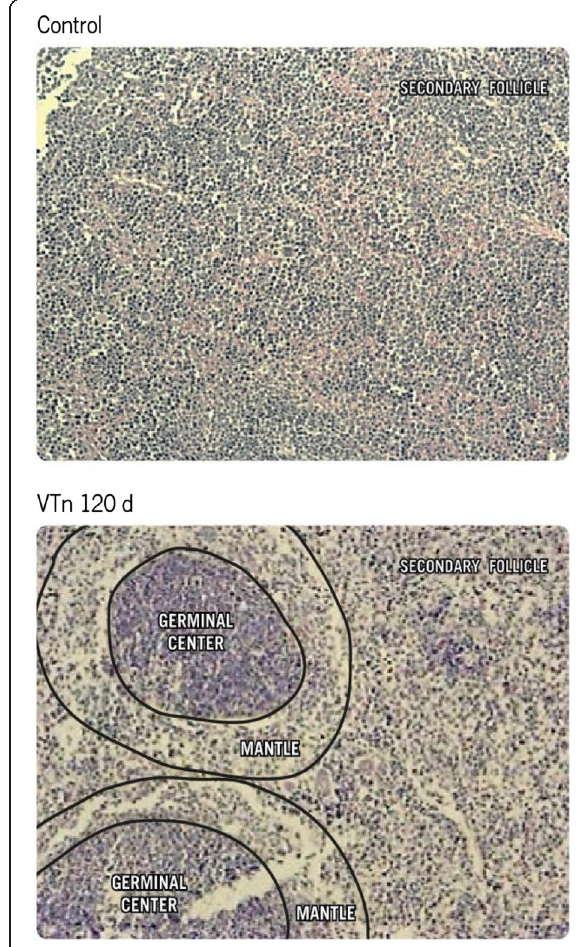
Figure 5 Venom promotes germinal center formation. BALB/c mice were immunized i.p. with 10 μ g of T. nattereri venom adsorbed in Al(OH) 3 on day 0 and boosted on day 14 with the same dose of venom. Animals injected only with Al(OH) 3 were considered as control group. After 120 days of immunization is observed typical B cell areas in lymphoid follicles of spleen showing an increased expansion of germinal centers compared with than